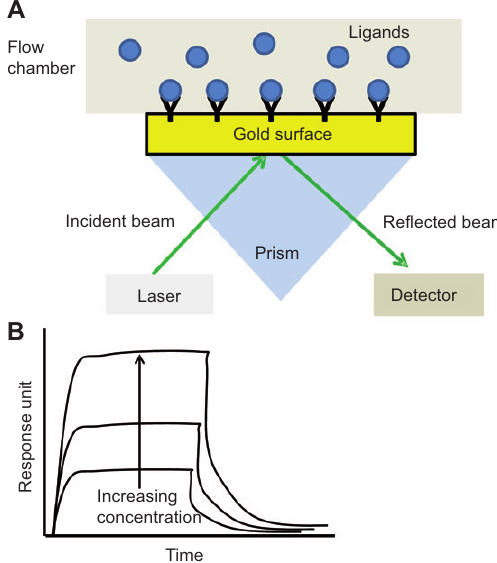
Figure 8 (A) Illustration of the SPR system. Ligands are immobilized onto a gold surface. Light is passed through a laser onto the gold surface and the reflected beam is sent to the detector. When proteins are present and bind to the immobilized ligand, the detector can measure the shift in the wavelength. (B) Sketch of an output graph of signal over time from SPR analysis that is measured by a detector and can be converted into kinetic